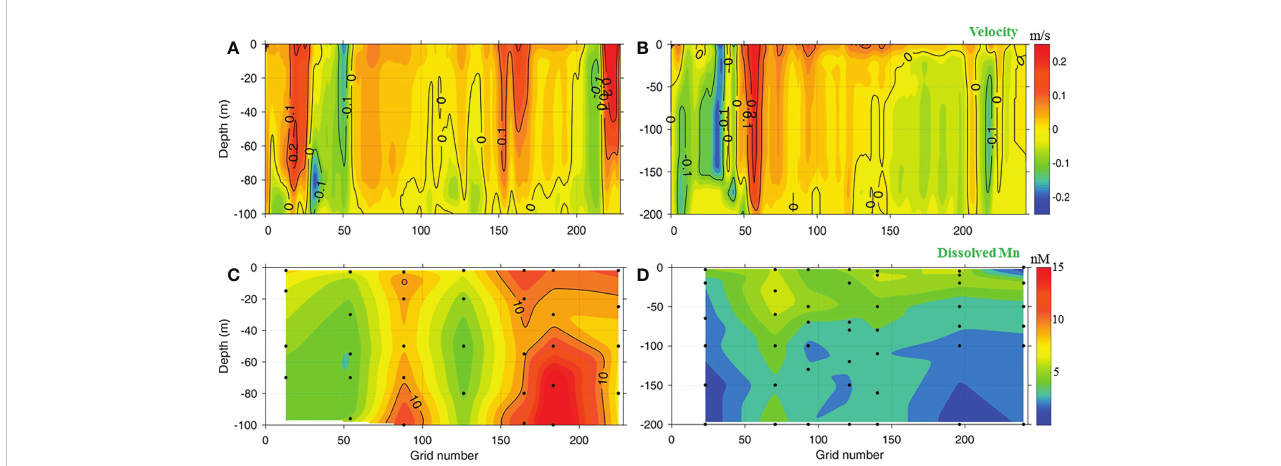
FIGURE 12 Current velocity distributions (m/s, A, B ) and dissolved Mn distributions (nM, C, D ) along the 100 – and 200 – m isobaths originating from Taiwan (+: off – shelf, – : on – shelf). Grid numbers represent locations used for the water budget calculation along the 100 – and 200 – m isobaths. Detailed information can be found in Figure 2. Part of the dissolved Mn data (Grid number > 180) comes from unpublished data from other cruises.